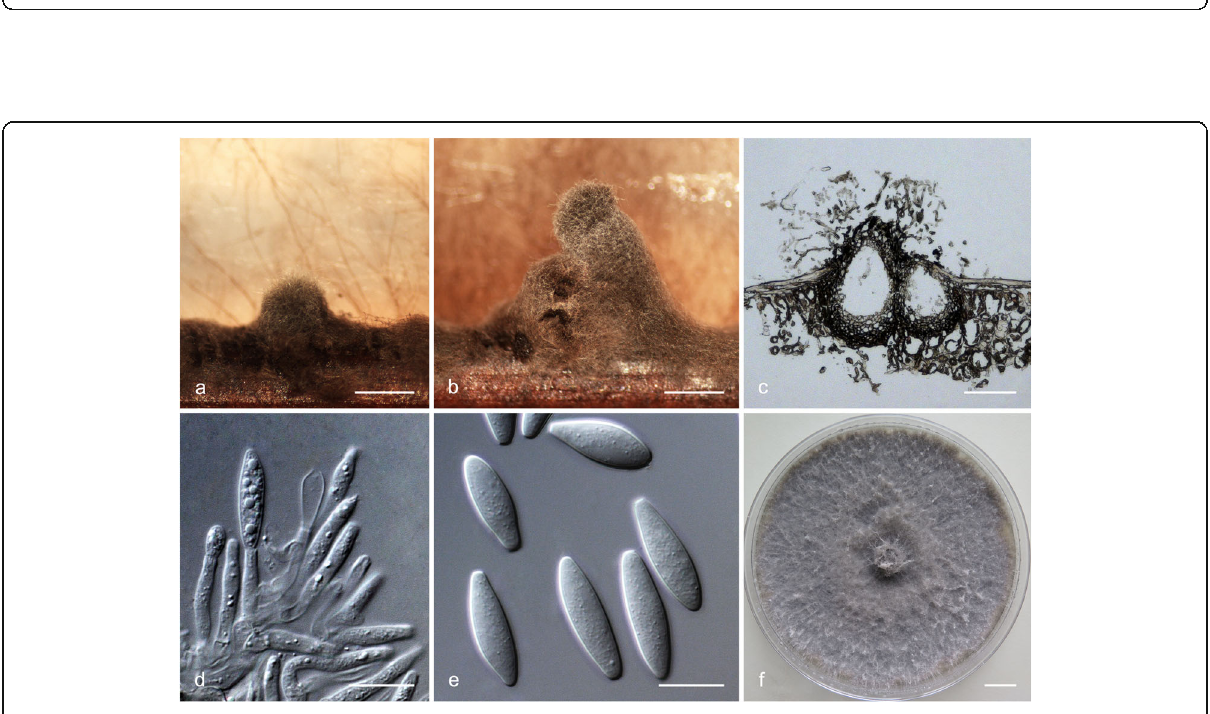
Fig. 5 Botryosphaeria puerensis. a . Conidiomata formed on pine needle culture; b , c . Longitudinal section through conidiomata; d , e . Conidiogenous cells and developing conidia; f . Conidia; g . Living culture after 10 d on 2% MEA (front). Scale bars: a=500 μ m; b, c=100 μ m; d – f=10 μ m;